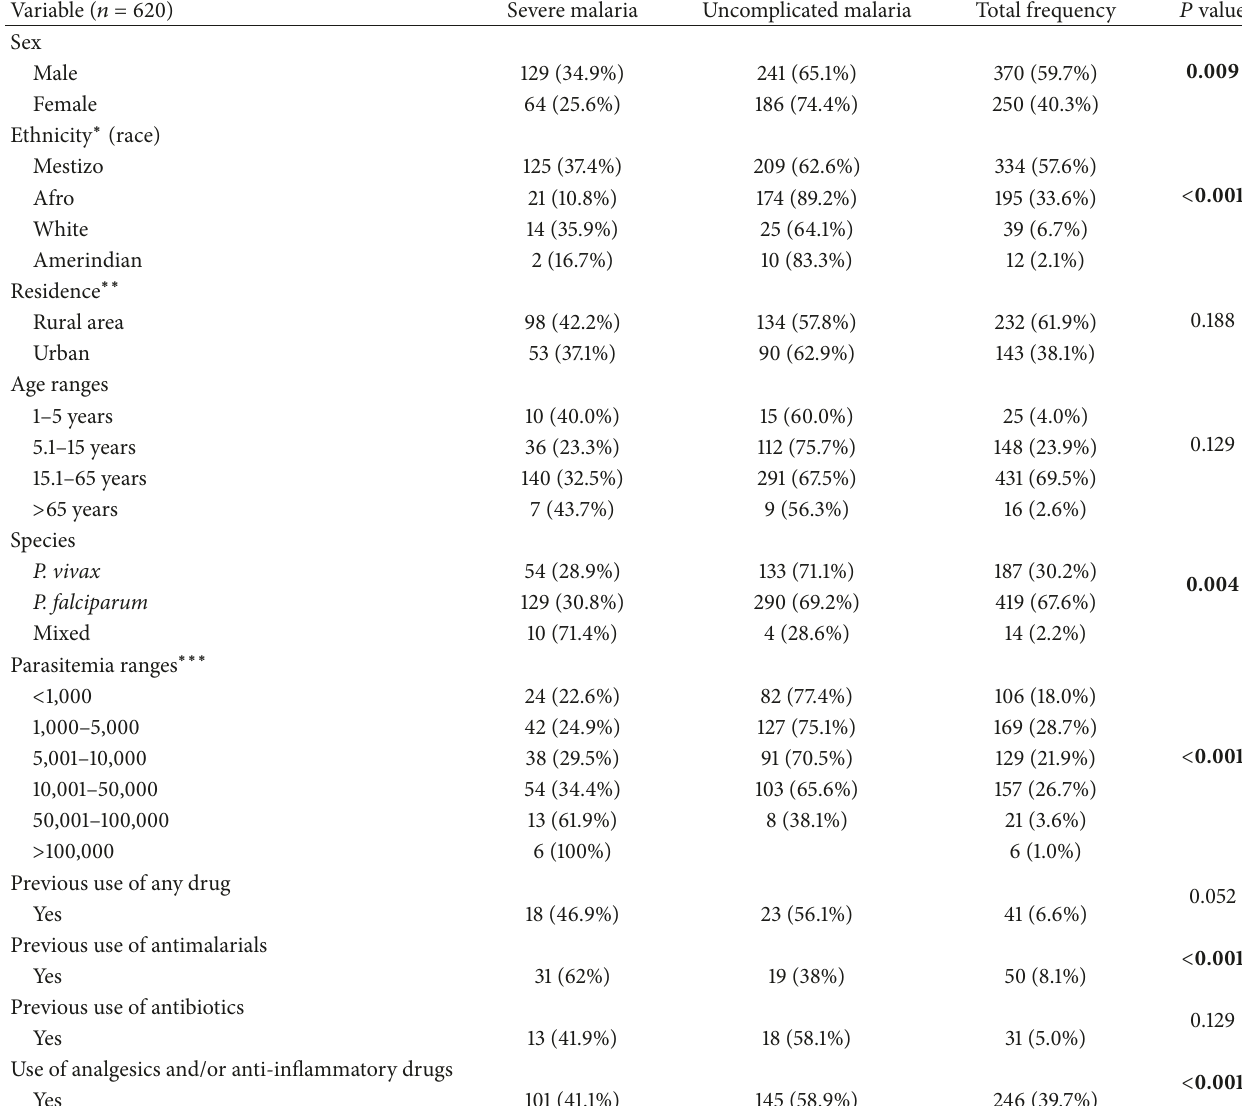
Table 1: Sociodemographic